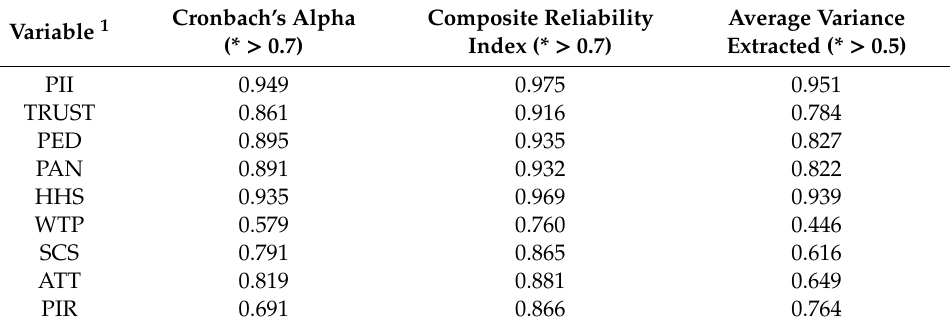
Table 3. Reliability of the measurement.